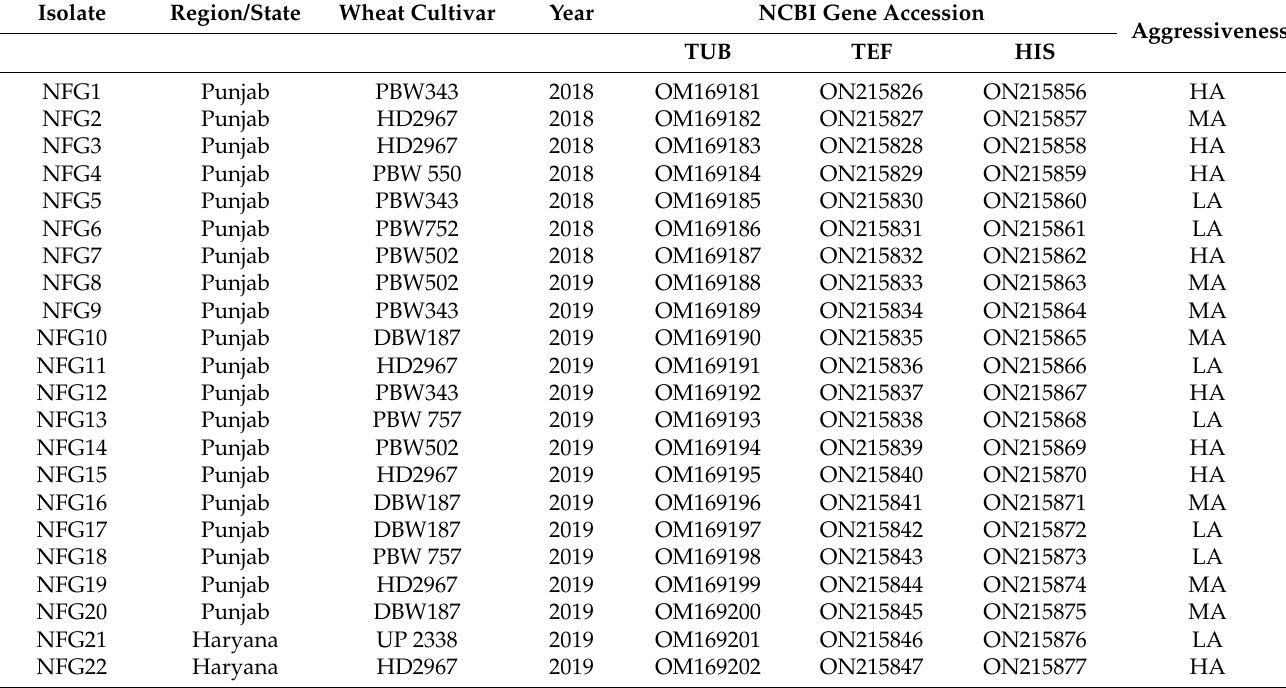
Table 1. FG isolates used in the current